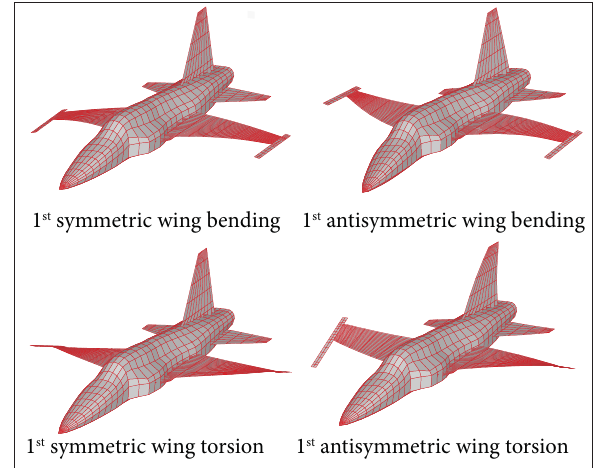
Figure 10. Aircraft selected mode shapes for correlation with experiments.